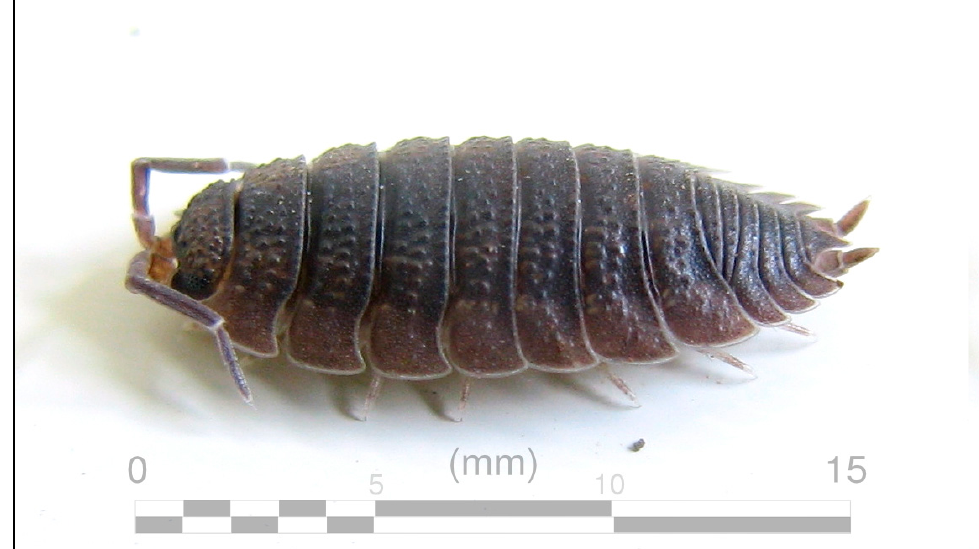
Figure 1. An Adult Porcellio scaber . Creative Commons: https://en.wikipedia.org/wiki/Porcel- lio_scaber#/media/File:Porcellio_scaber_(AU)-left_01.jpg, (accessed on November 29,